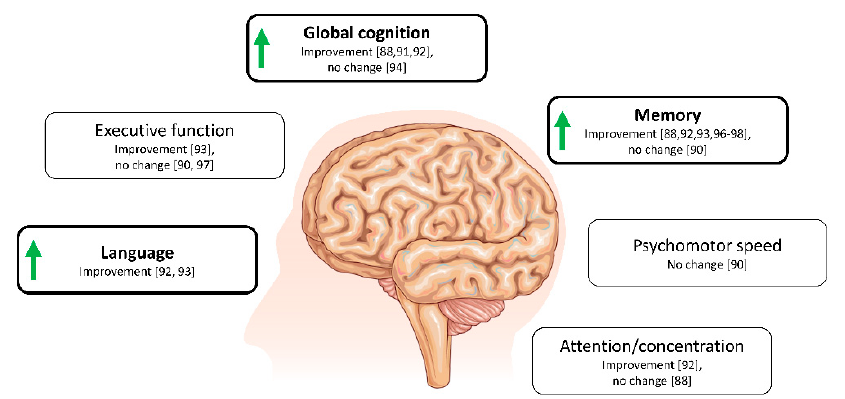
Figure 3. Overview of cognitive domains affected by ketogenic interventions in patients with mild cognitive impairment or AD. Overall improvements are demonstrated by green arrows. Illustration is solely based on studies using a randomized-controlled study design (cross-over or parallel groups). Interventions included ketogenic diets [97,98] or supplementation with MCFAs [88,90–94,96] ranging from acute (90 min after ingestion) to 6 months in duration and studies include between 12 and 413 participants.